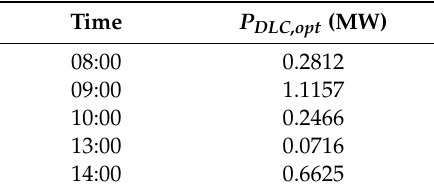
Table 9. The cost analysis and required capacity of the DLC methods.